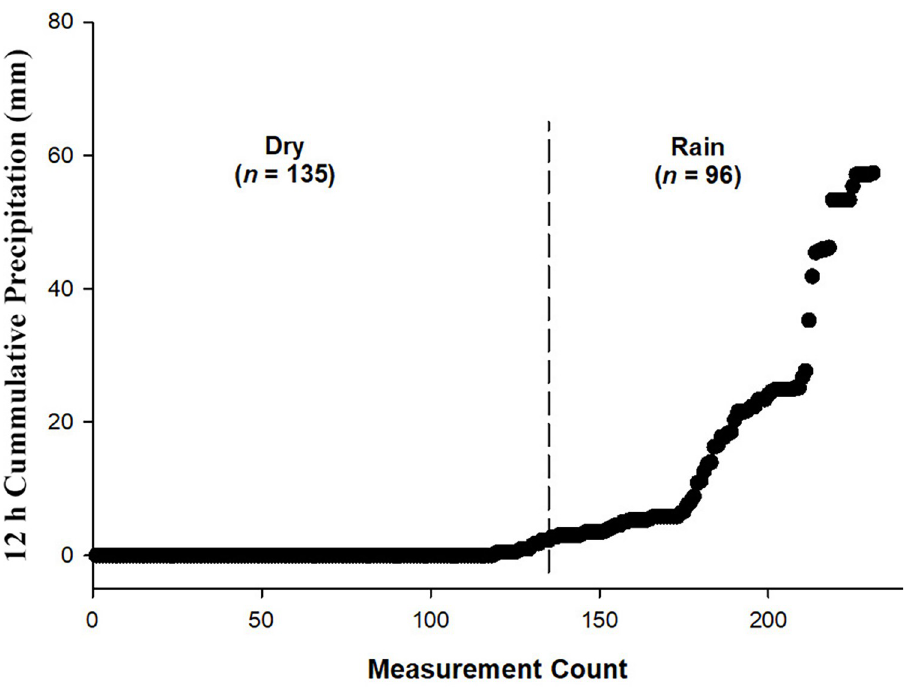
Fig 2. Precipitation measurements ( n = 231) ranked from lowest to highest quantities (values increase from left to right). The vertical dashed line denotes number of samples with precipitation level < 2.54 mm.